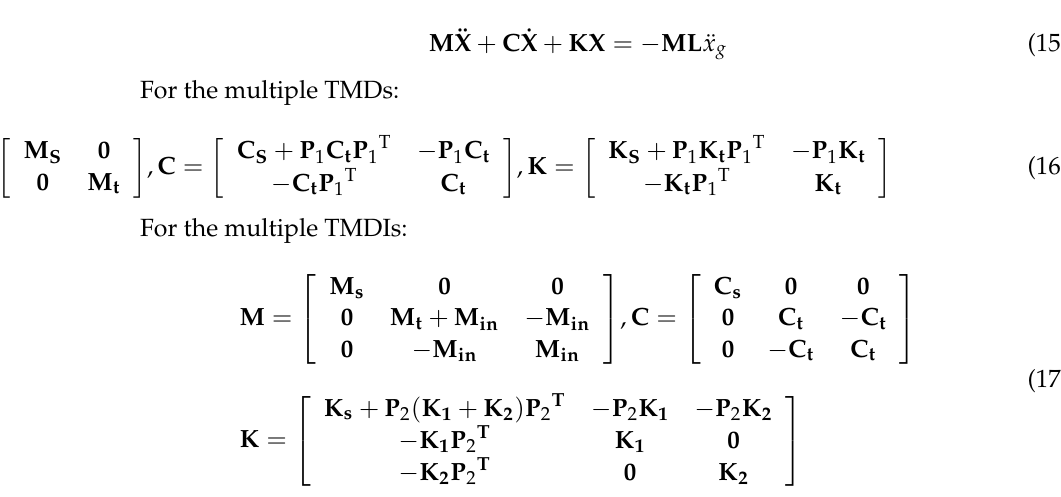
Figure 16. The entire structure assembled with multiple passive and active DVAs. When the parameters of each device are determined, the equation of motion of the whole system under the base acceleration excitation is expressed as in the following formu-